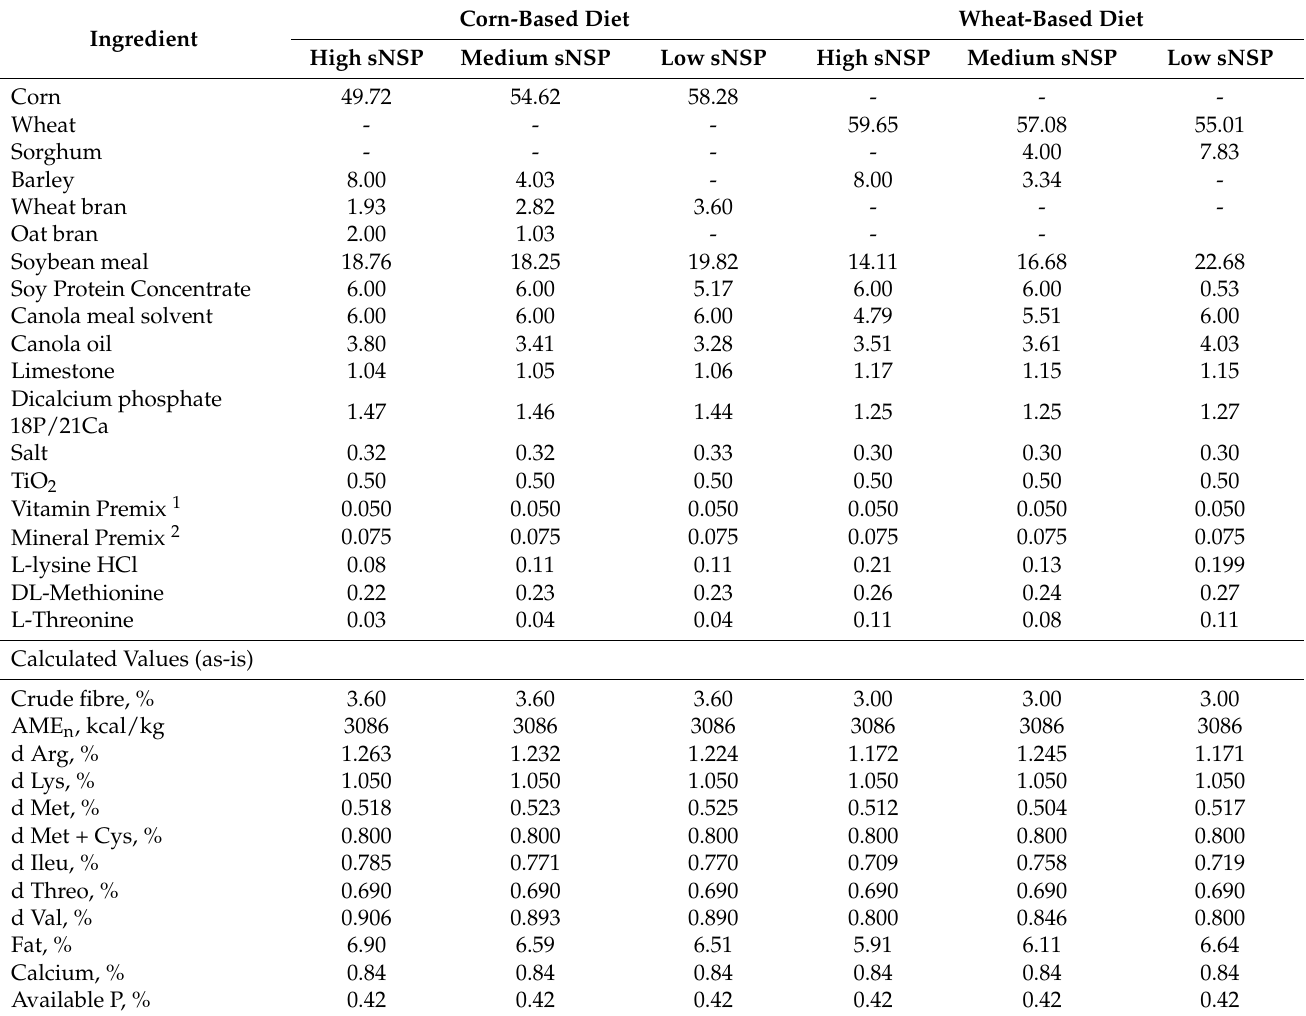
Table 3. Composition of the grower diets (g/100 g, as fed